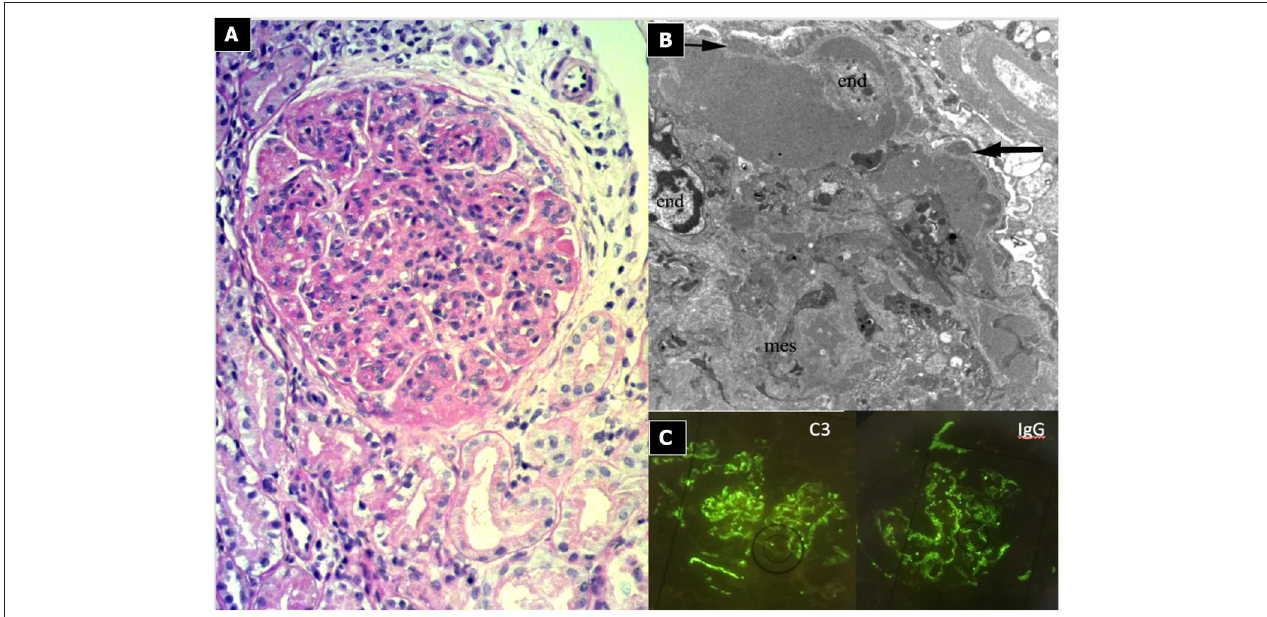
FIGURE 3 | Immunocomplex-mediated membrano-proliferative GN. (A) LM (PAS stain): diffuse and global increase of glomerular tuft cellularity (lobular pattern) with thickening of the glomerular capillary walls (membranoproliferative pattern). (B) Arrows indicate GBM splitting due to mesangial interposition (white arrow where) and presence of mesangial and sub-endothelial deposits (black arrow). (C) IF shows IgG and C3 co-dominant positivity. it can independently affect prognosis (11, 83, 84).